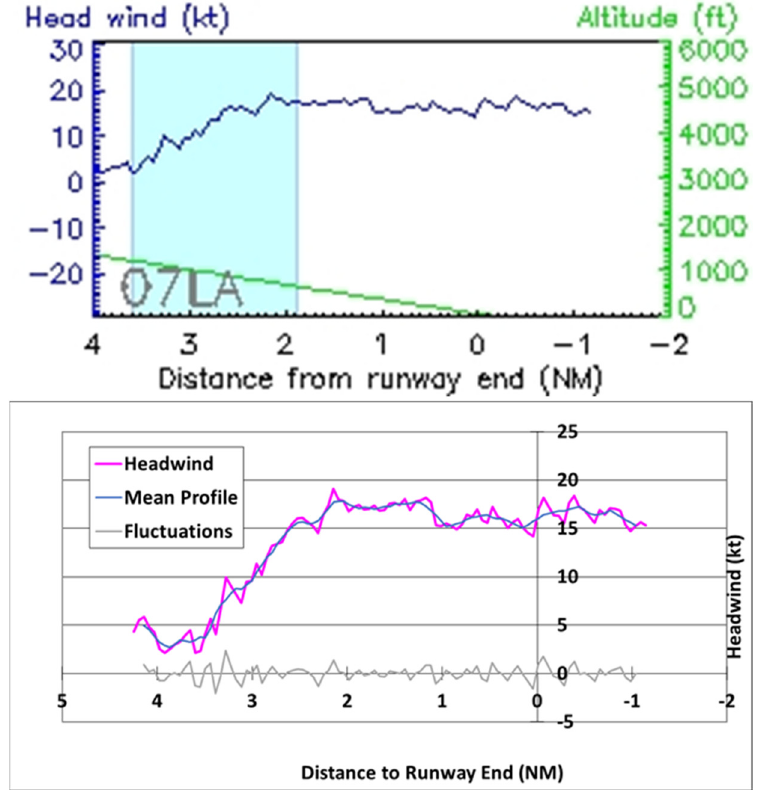
Figure 4. Headwind profile and windshear alert (highlighted in blue) issued by GLYGA for a case in 20 November 2012 ( top ). Analysis using the GRR procedures is shown in the ( bottom ).